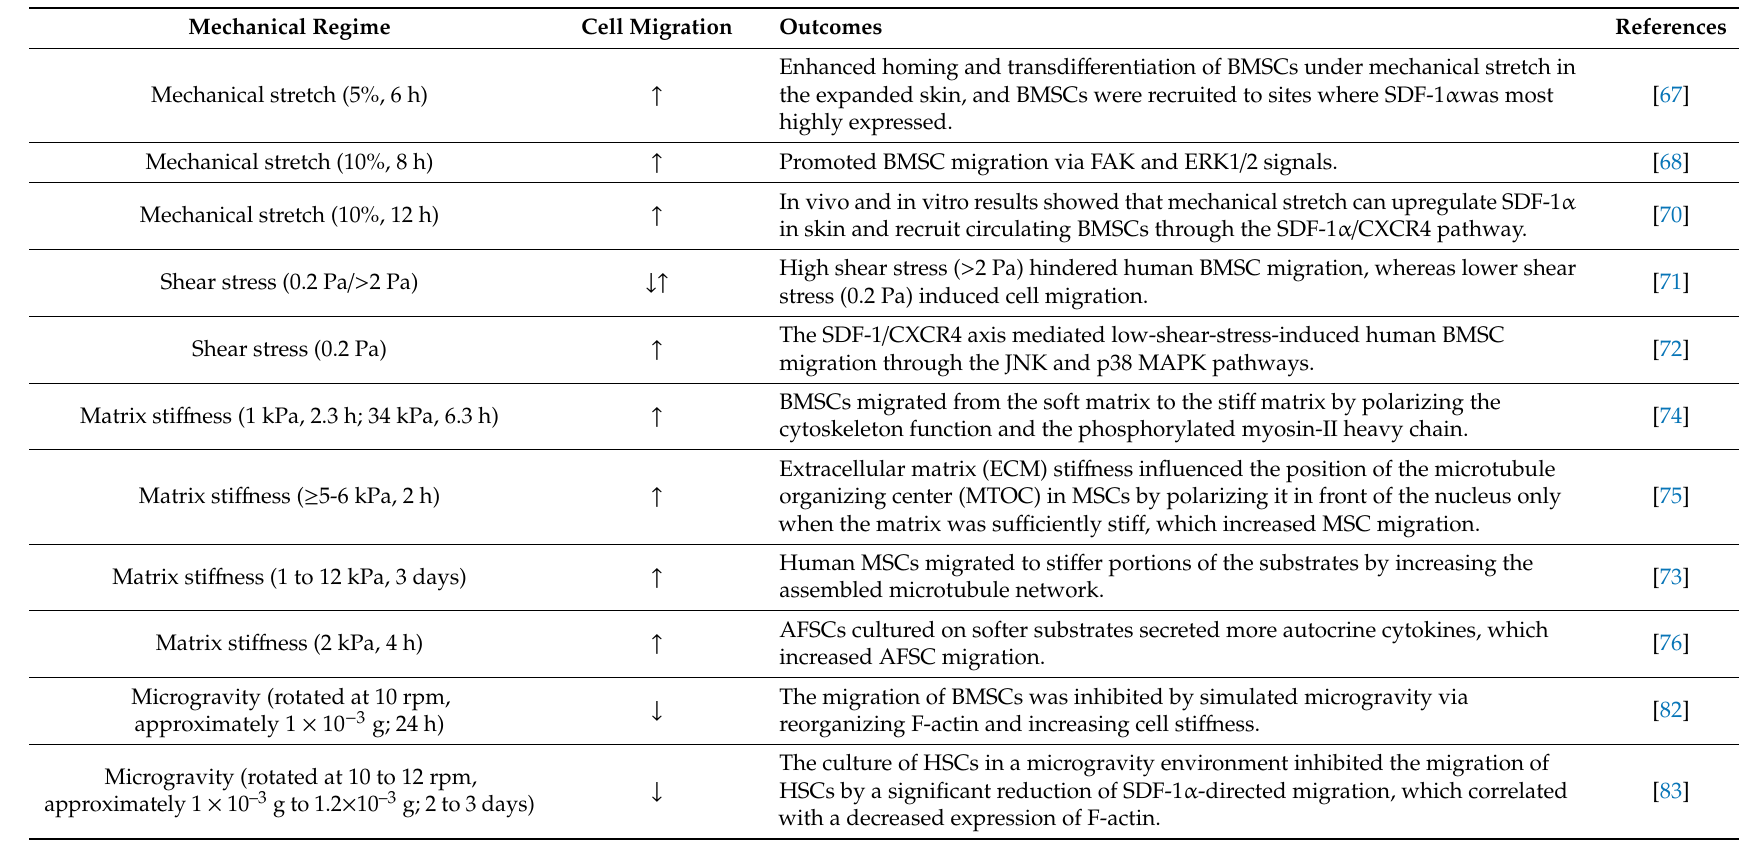
Table 2. E ff ect of mechanical factors on BMSC